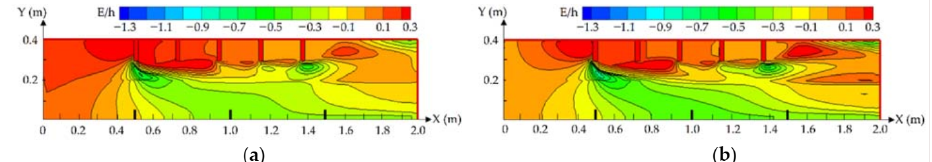
Figure 12. Overview of the simulated non-dimensional bed changes around multiple spur dikes: ( a ) case G4a and ( b ) case G5a. E is the scour depth, and h is the average water